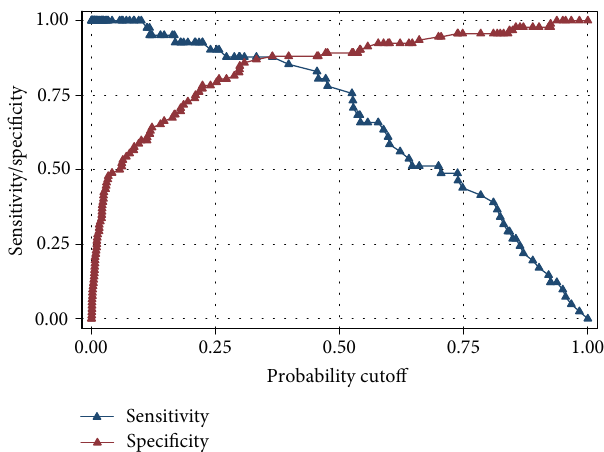
Figure 2: Postestimation sensitivity/speci fi city plot for the fi nal step of the model (the unit of the predictor is the scoring system).